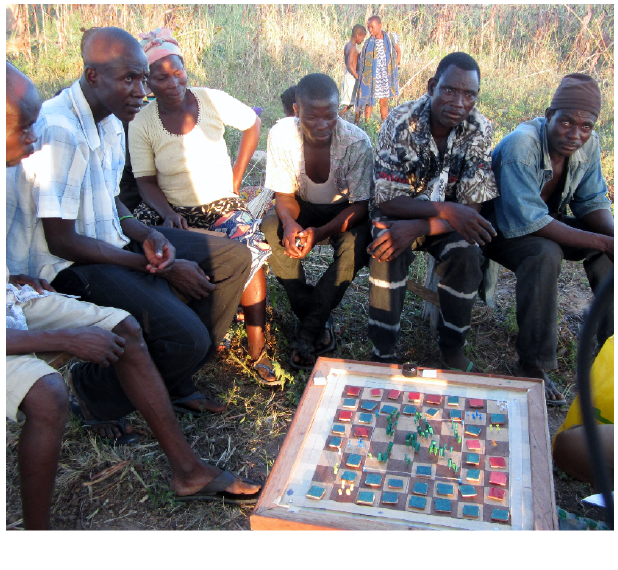
Fig. 4 . Game board and die with the local farmers during the